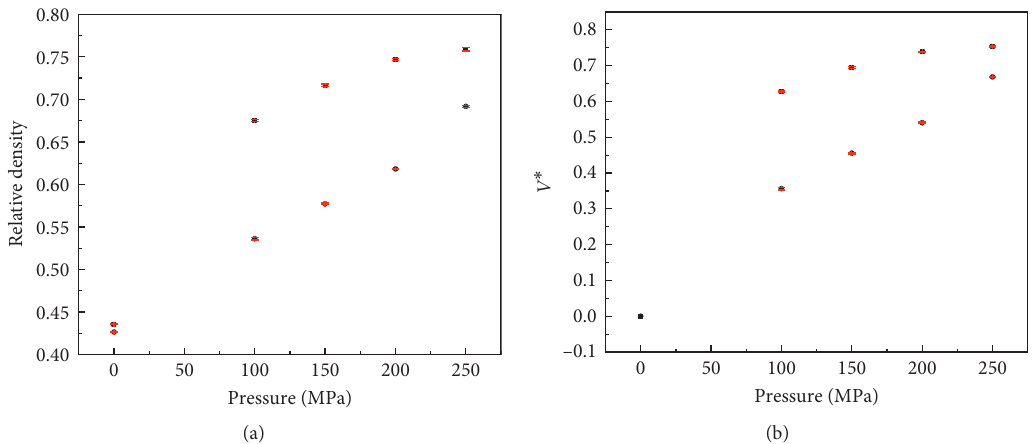
Figure 13: Comparison of relative density (a) and V ∗ parameter (b) versus pressure for coarse TiH example of different compaction behavior for these materials. ■ —TiH 2 and ●